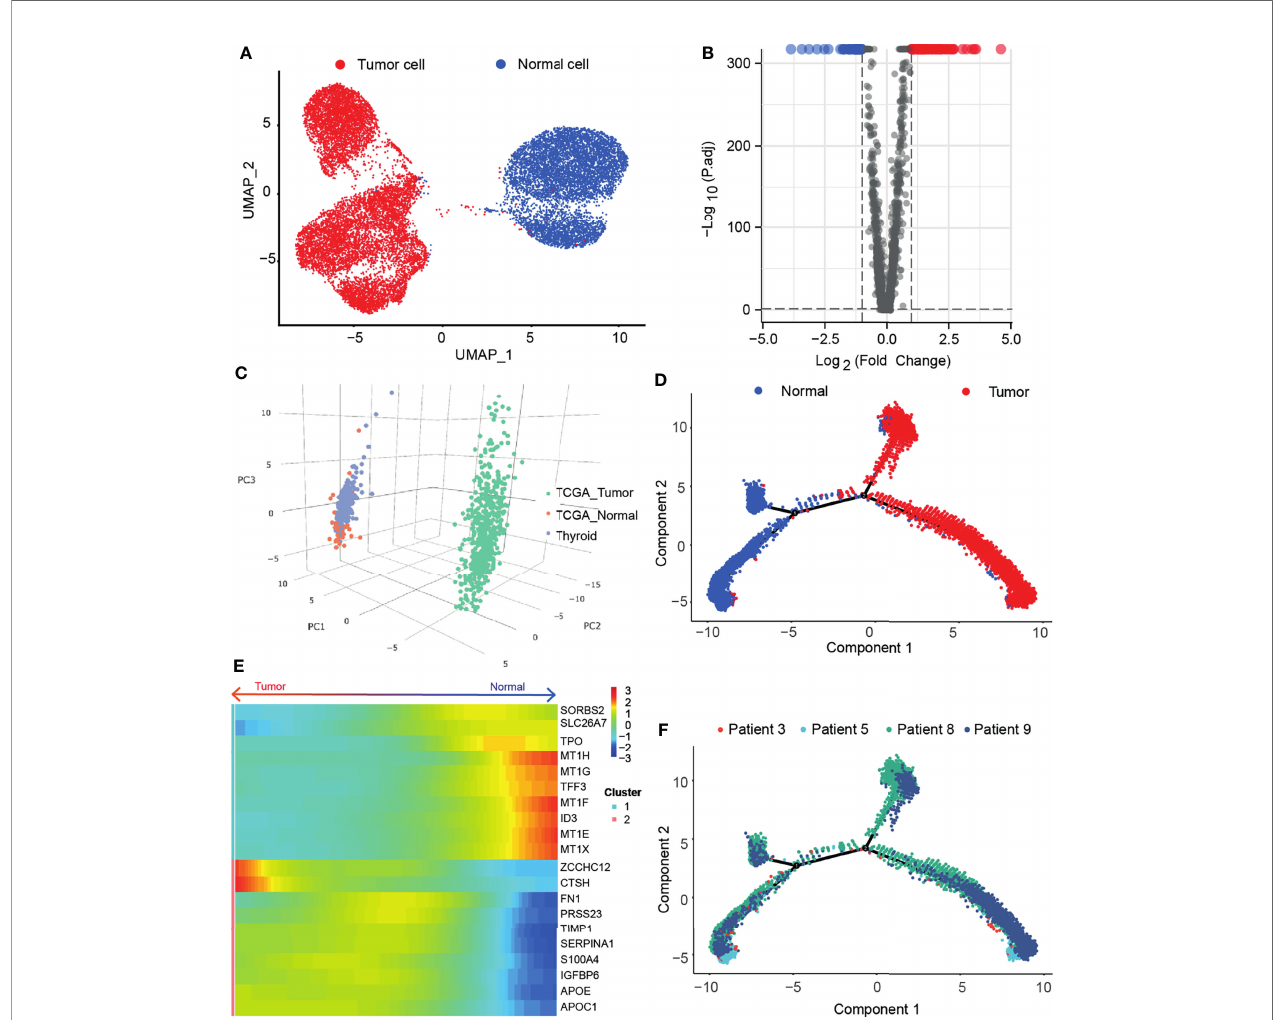
FIGURE 1 | Single cell sequencing reveals differentially expressed genes in thyroid papillary carcinoma. (A) Umap of tumor cells and adjacent normal cells in paired samples of 4 PTC patients. (B) Volcano map of DEGs. (C) PCA of 130 DEGs in THCA and GETx. (D) Pseudotime analysis of malignant transformation of normal cells. (E) Heatmap of the 10 most signi fi cantly upregulated and downregulated genes among the DEGs. (F) Patient information in the transformation trajectory from normal cells to malignant